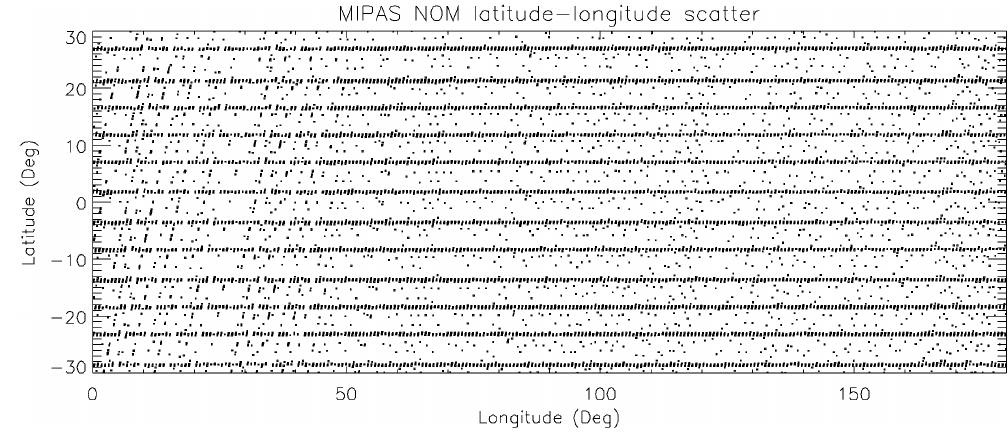
Fig. 3. Geolocation of the retrieved NOM profiles (latitude versus longitude) in the equatorial region for the complete FR